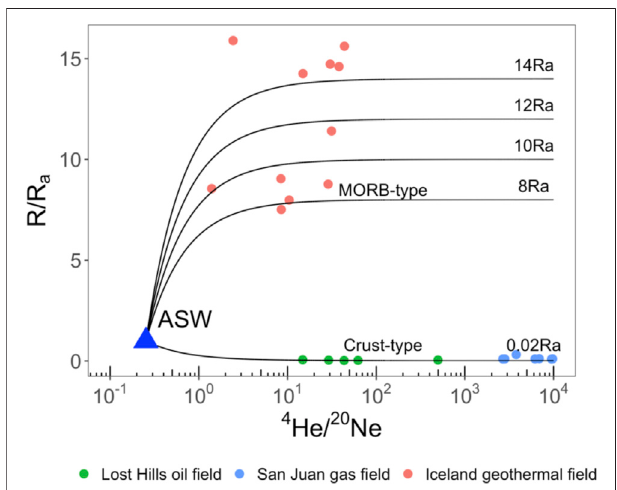
FIGURE 1 | R/R a ratio as a function of 4 He/ 20 Ne ratio for collected fl uid samples. All data can be explained as a mixture of three components (Air, Crust, and Mantle). R is the measured 3 He/ 4 He ratio, and R a is the 3 He/ 4 He ratio of air (1.4 × 10 – 6 ) (Mamyrin, 1970; Clarke et al., 1976). ASW represents the endmember of noble gases derived from Air Saturated Water. See details in Section “ Three Different Sources. ” Data sources: Lost Hills oil fi eld (Barry et al., 2018), San Juan gas fi eld (Zhou et al., 2005), and Iceland geothermal fi eld (Byrne et al.,